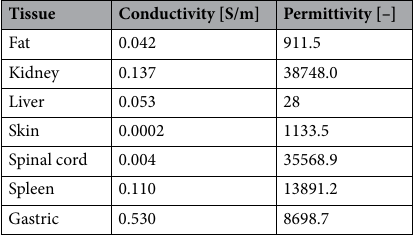
Table 1. Dielectric properties of human abdomen tissues 17 .